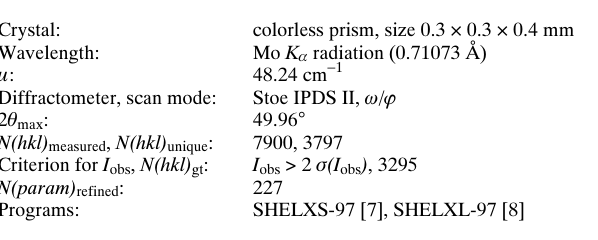
Table 1. Data collection and handling.